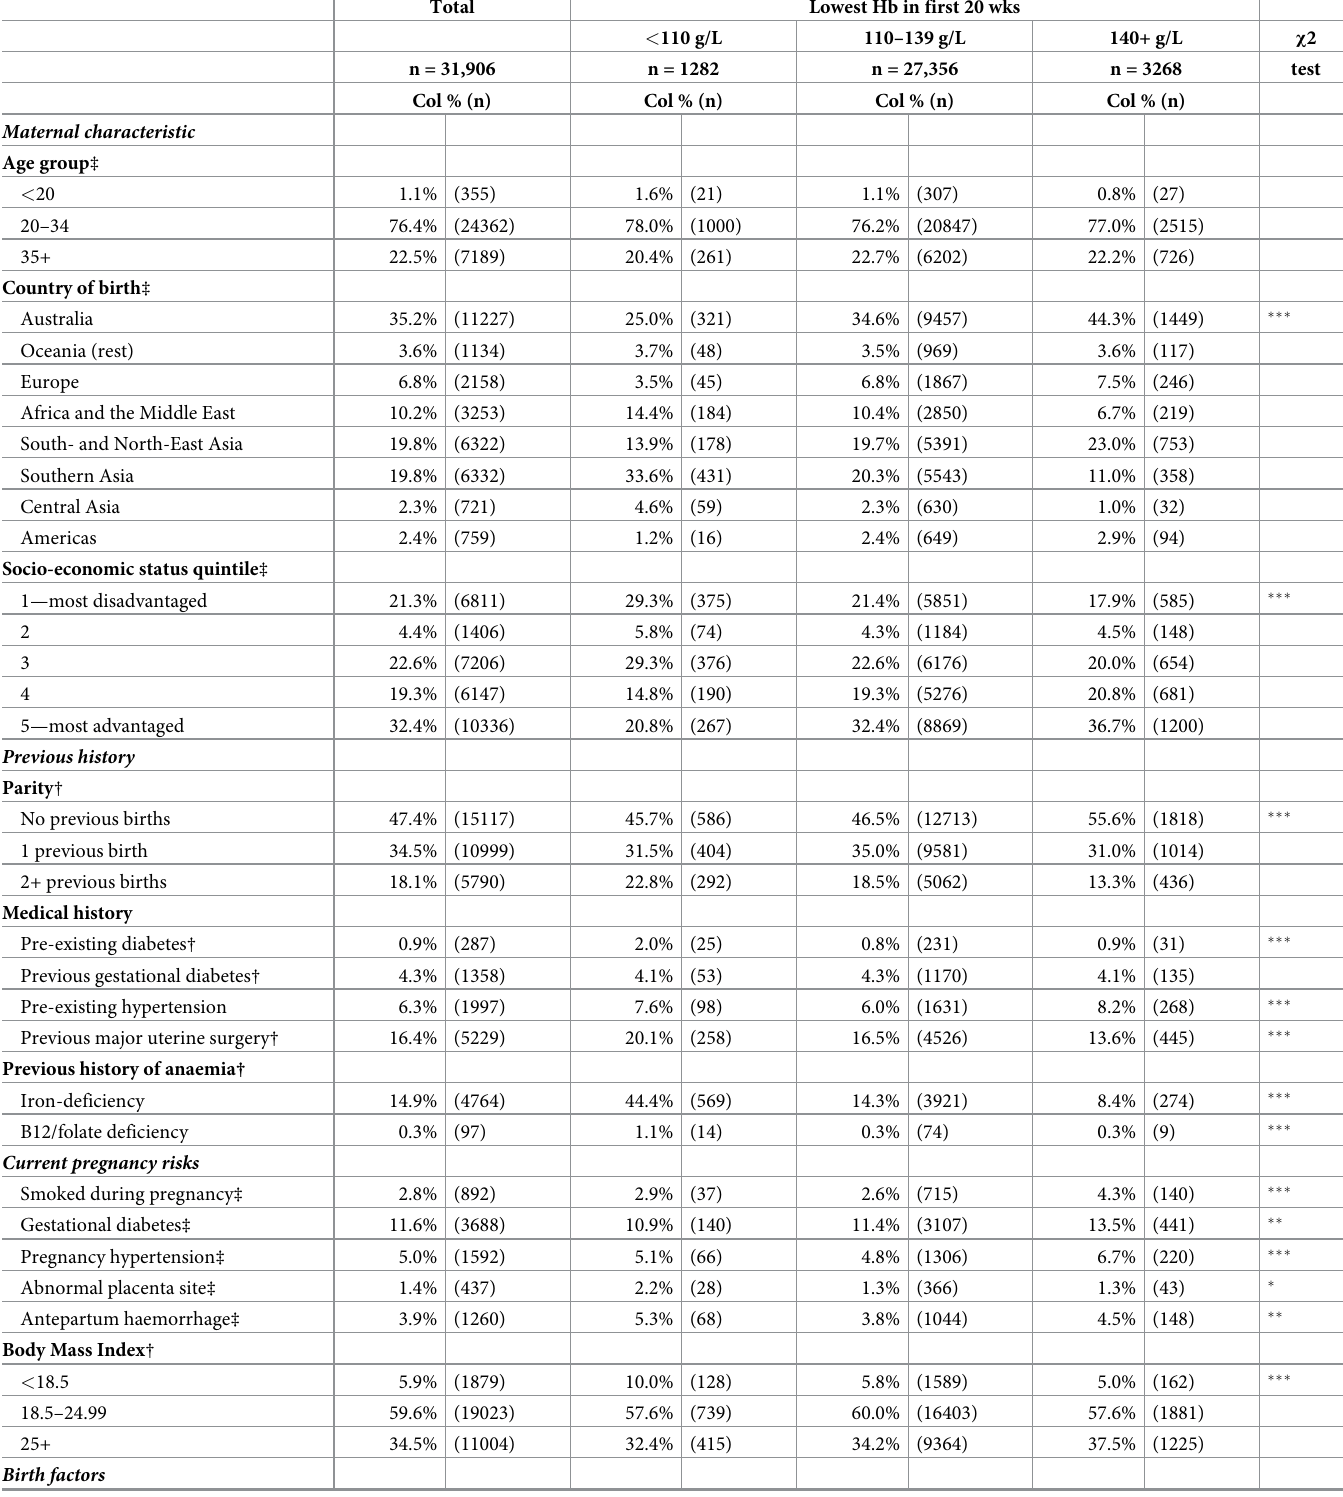
Table 1. Characteristics of the population by hospital of birth and haemoglobin (Hb)